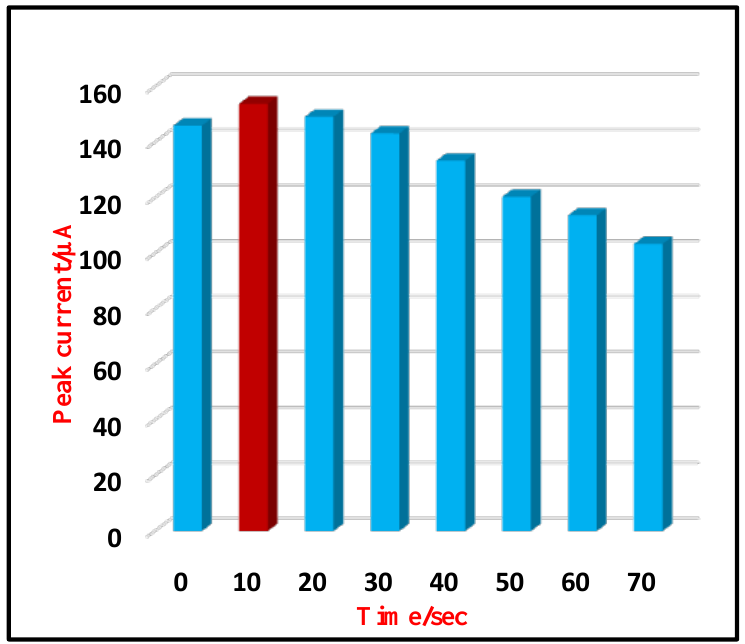
Figure 4. Plot of Ip and immersion time (t imm ) for 0.5 mM TMP.